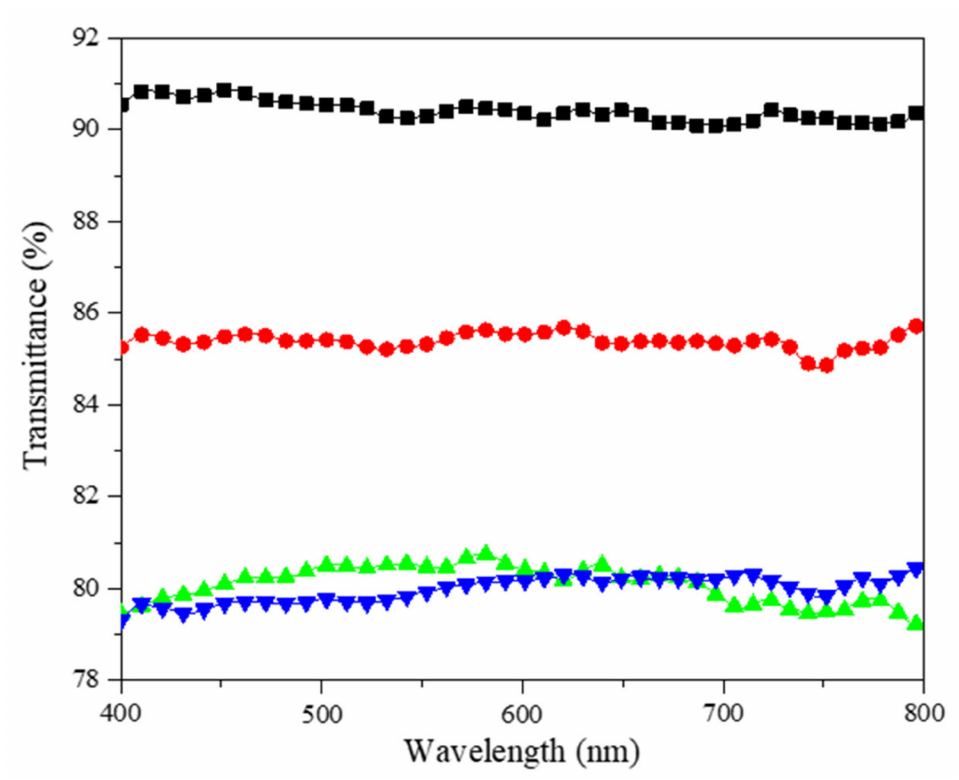
Figure 7. Transformation in transmittance of F-P film. Before spray simulation (- (cid:4) -); spray simulation for 2 min (- • -); for 4 min (- (cid:78) -); for 6 min (- (cid:72)